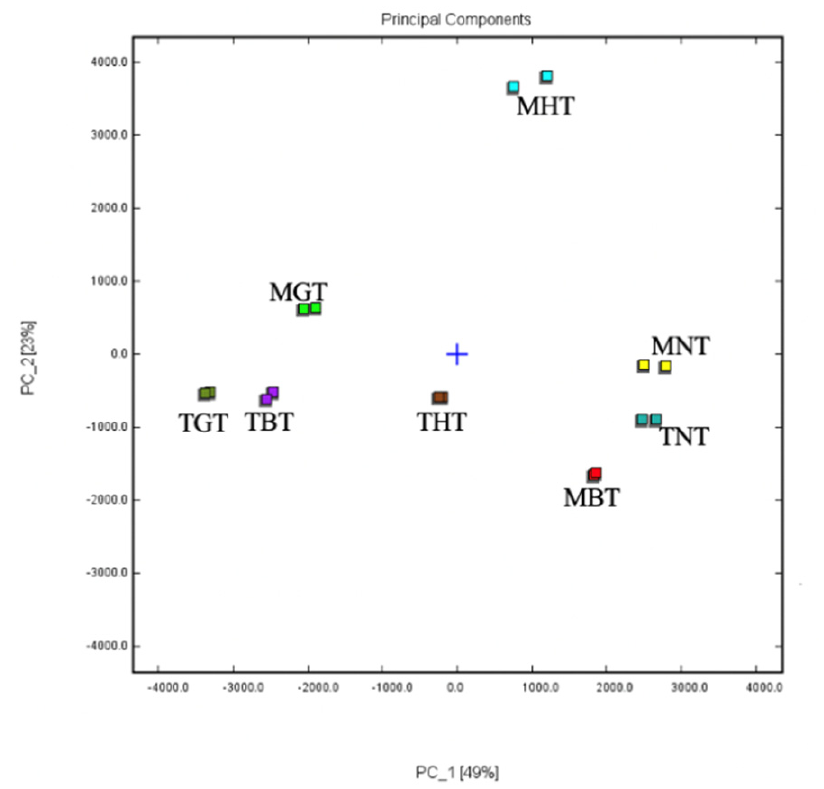
Figure 2. PCA of volatile compounds of eight types of lotus ‐ leaf tea detected via HS ‐ GC ‐ IMS. TNT, tender naturally ‐ dried lotus ‐ leaf tea; THT, tender hot air ‐ dried lotus ‐ leaf tea; TGT, tender green lo ‐